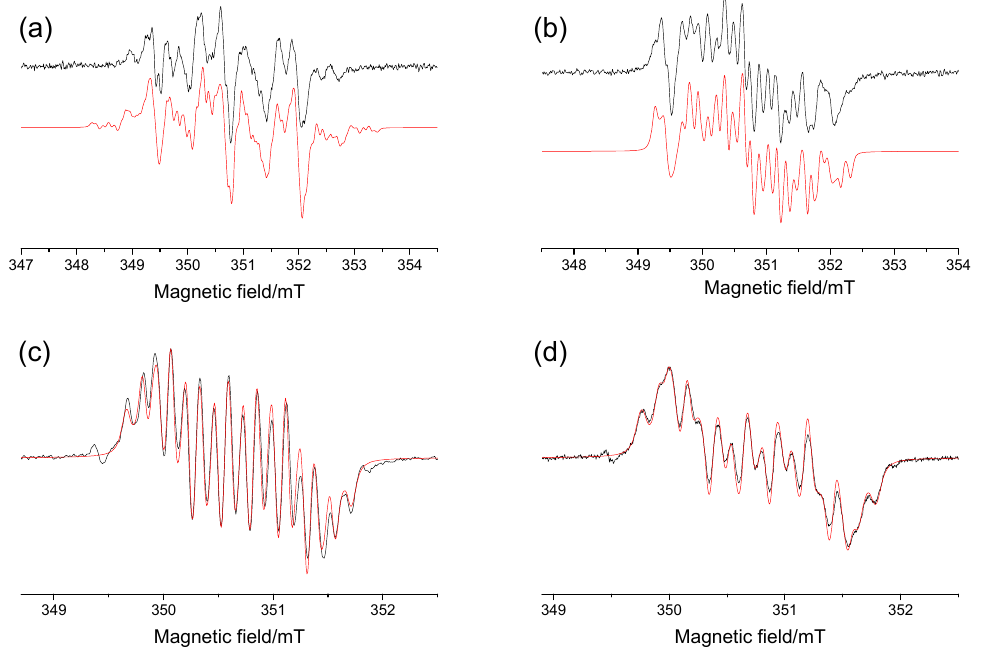
Figure 2. EPR spectra recorded for diluted and oxygen-free toluene solutions of HPNs at 295 K: ( a ) 22a , ( b ) 22b , ( c ) 22c , and ( d ) 22d . Black curve: experimental spectra; red curve: simulated spectra with the parameters listed in Table 3.